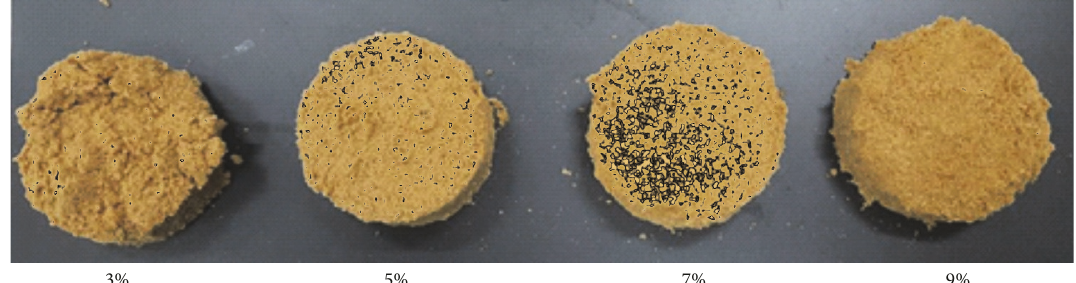
Figure 10: Photos of reinforcement layers taken from the specimens with curing time of 24 h after the constant head permeability tests.